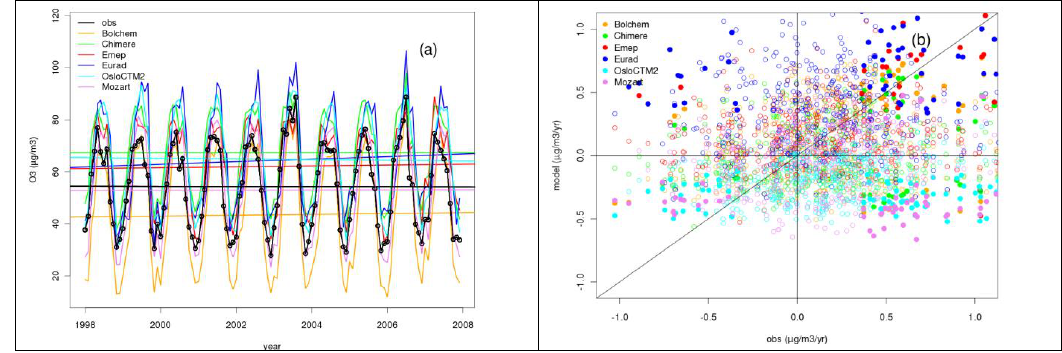
Figure 10 : Same as Figure 8 for O 3 . Fig. 10. Same as Fig. 8 for O 3 .